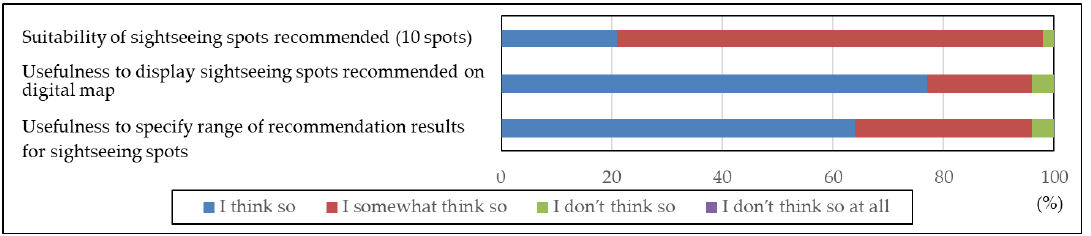
Figure 10. Evaluations concerning the recommendation function of sightseeing spots adopting collaborative